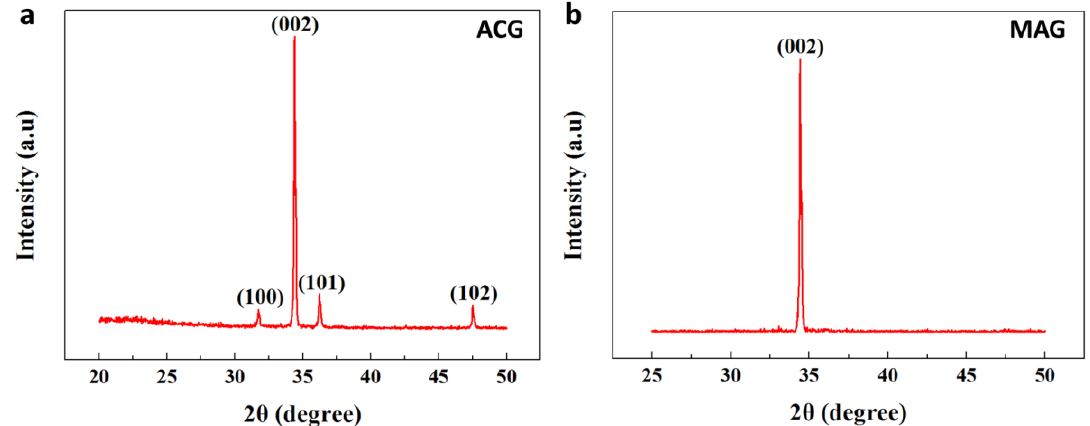
Figure 5. ZNR X-ray diffraction (XRD) profiles: ( a ) the ACG and ( b ) the MAG method.